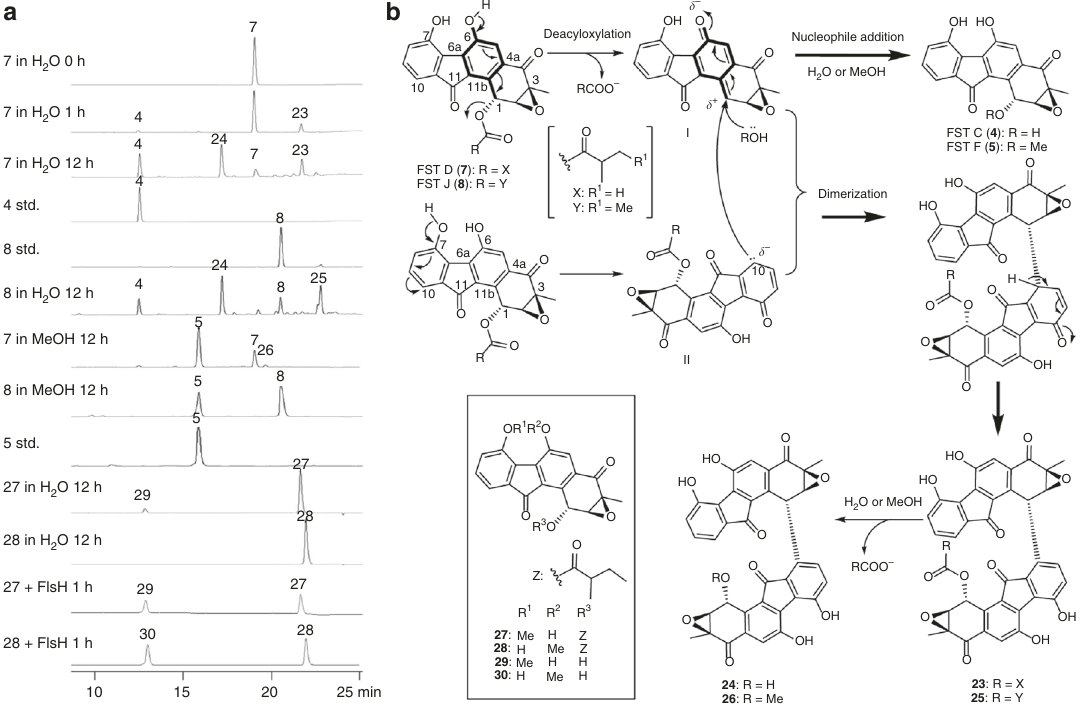
Fig. 5 Analysis of non-enzymatic reactions of acyl FSTs and the proposed two-step mechanisms. a HPLC analysis of non-enzymatic reactions of acyl FSTs. The general conditions for incubation were set as: substrate ( 7 , 8 , 27 or 28 ) 100 µ M, enzyme 10 µ M, 30 °C. b Proposed mechanisms for the spontaneous deacylation and accompanied dimerization. Chemical structures of compounds 27 − 30 are shown in a block as an